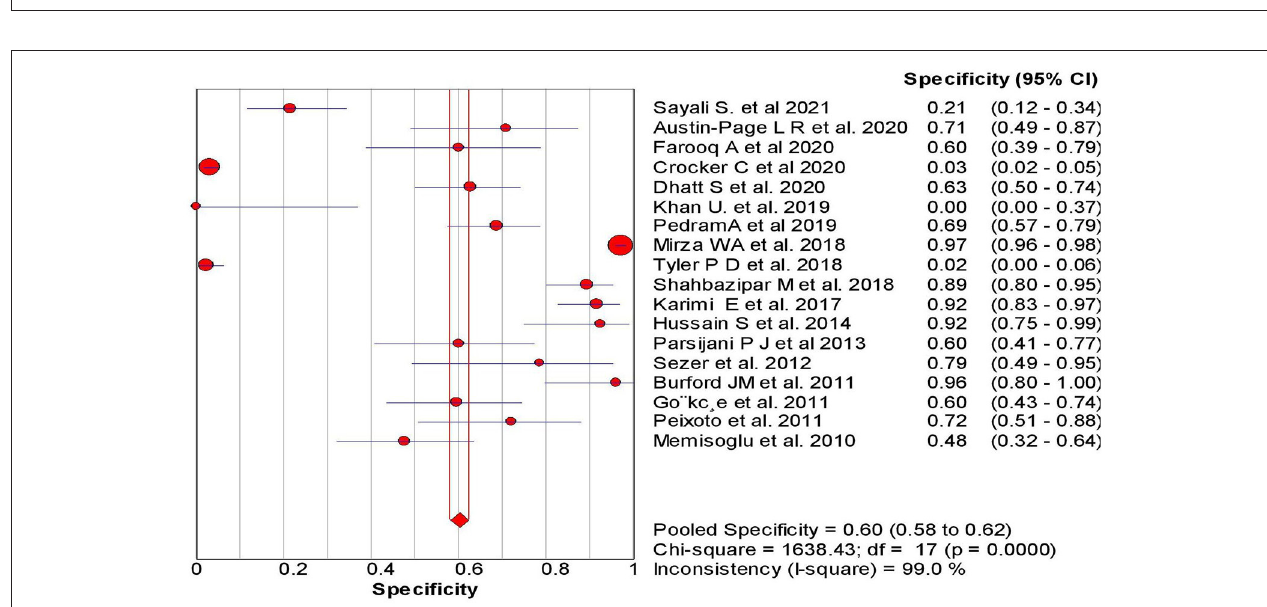
FIGURE 3 | Specificity of ultrasound in acute appendicitis